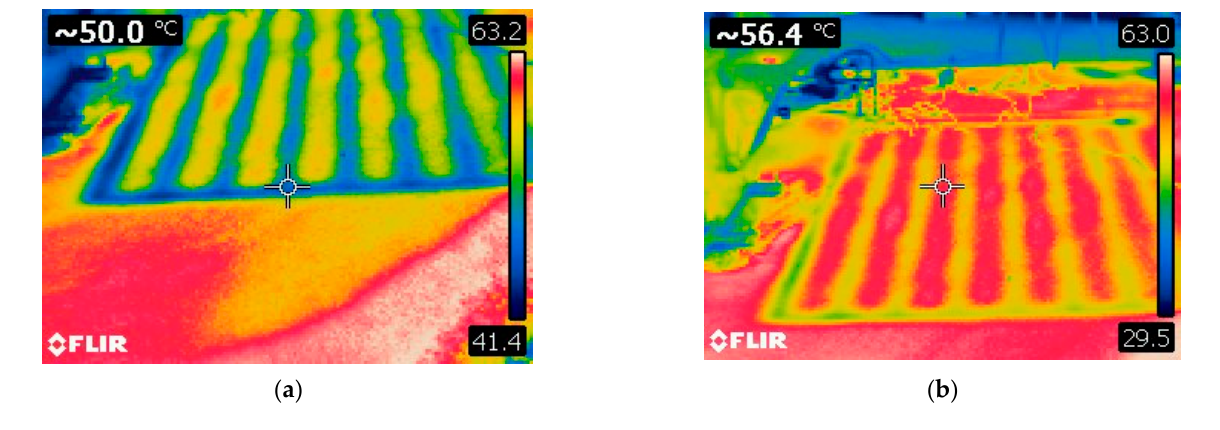
Figure 4. ( a ) Thermographic image of the area located ( a ) above the CSA and ( b ) between the CSA pipes.